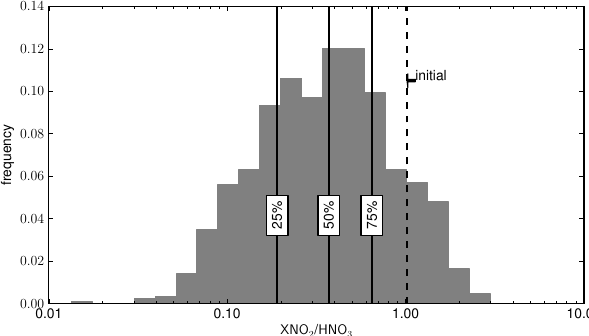
Fig. 2. Observed XNO 2 to HNO 3 ratio, from 8 to 10 km, with percentile markers (solid lines) and initial conditions threshold (dashed lines).